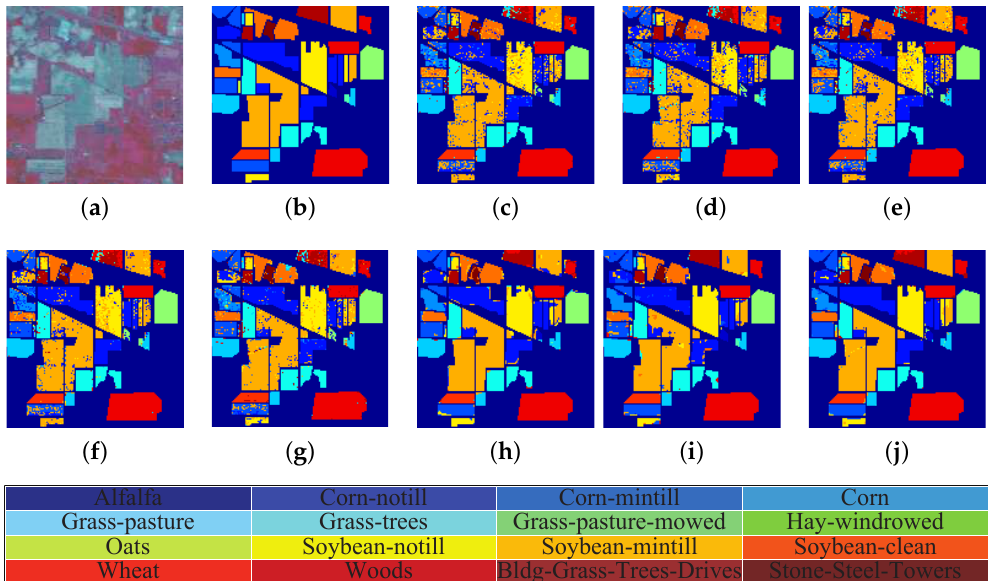
Figure 6. Classification maps of different methods for the Indian Pines dataset: ( a ) Pseudocolor image, ( b ) ground truth, ( c ) LPP, ( d ) NPE, ( e ) SGE, ( f ) LRGE, ( g ) LatLRPL, ( h ) MPCA, ( i ) TLPP, ( j ) SpaLatLRPL.